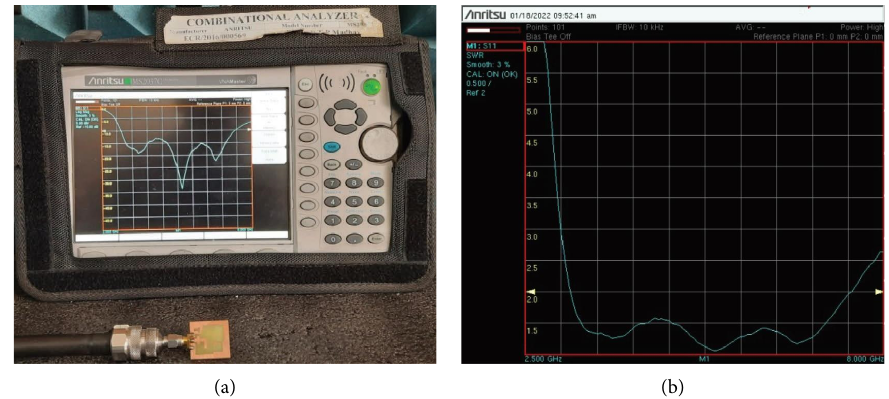
Figure 9: Fabricated antenna measurement of (a) return loss and (b) VSWR.